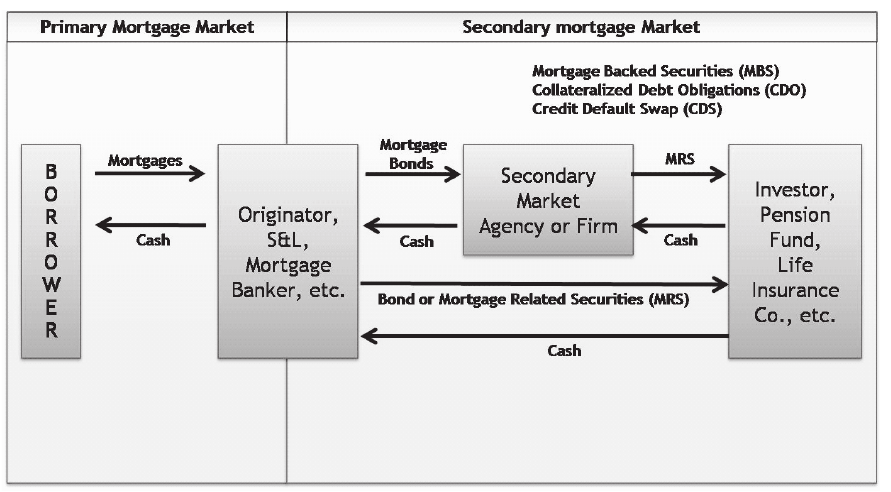
figure 1. mortgage market structure (Clauretie and sirmans,